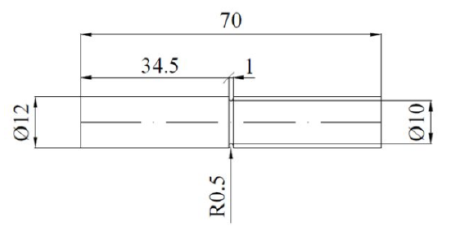
Figure 3. The test piece used for impact strength KC testing by a simplified method (dimensions in millimeters)